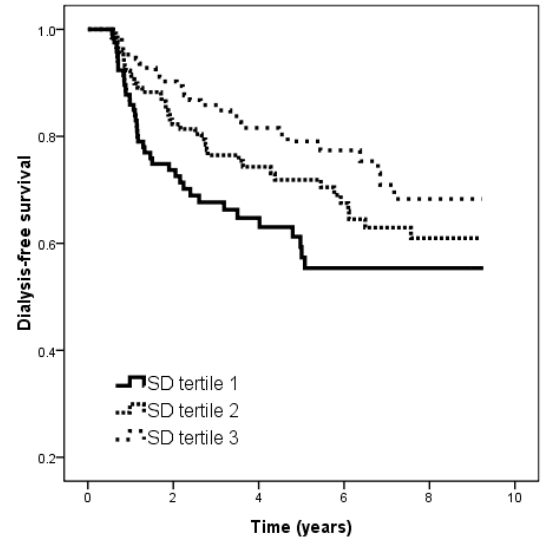
Figure 1. Kaplan–Meier analysis of dialysis-free survival according to tertiles of HbA 1C standard deviation (SD) (log-rank p = 0.012). Patients with tertile 3 of HbA 1C SD had a better renal-free survival than those with tertile 1 of HbA 1C SD.